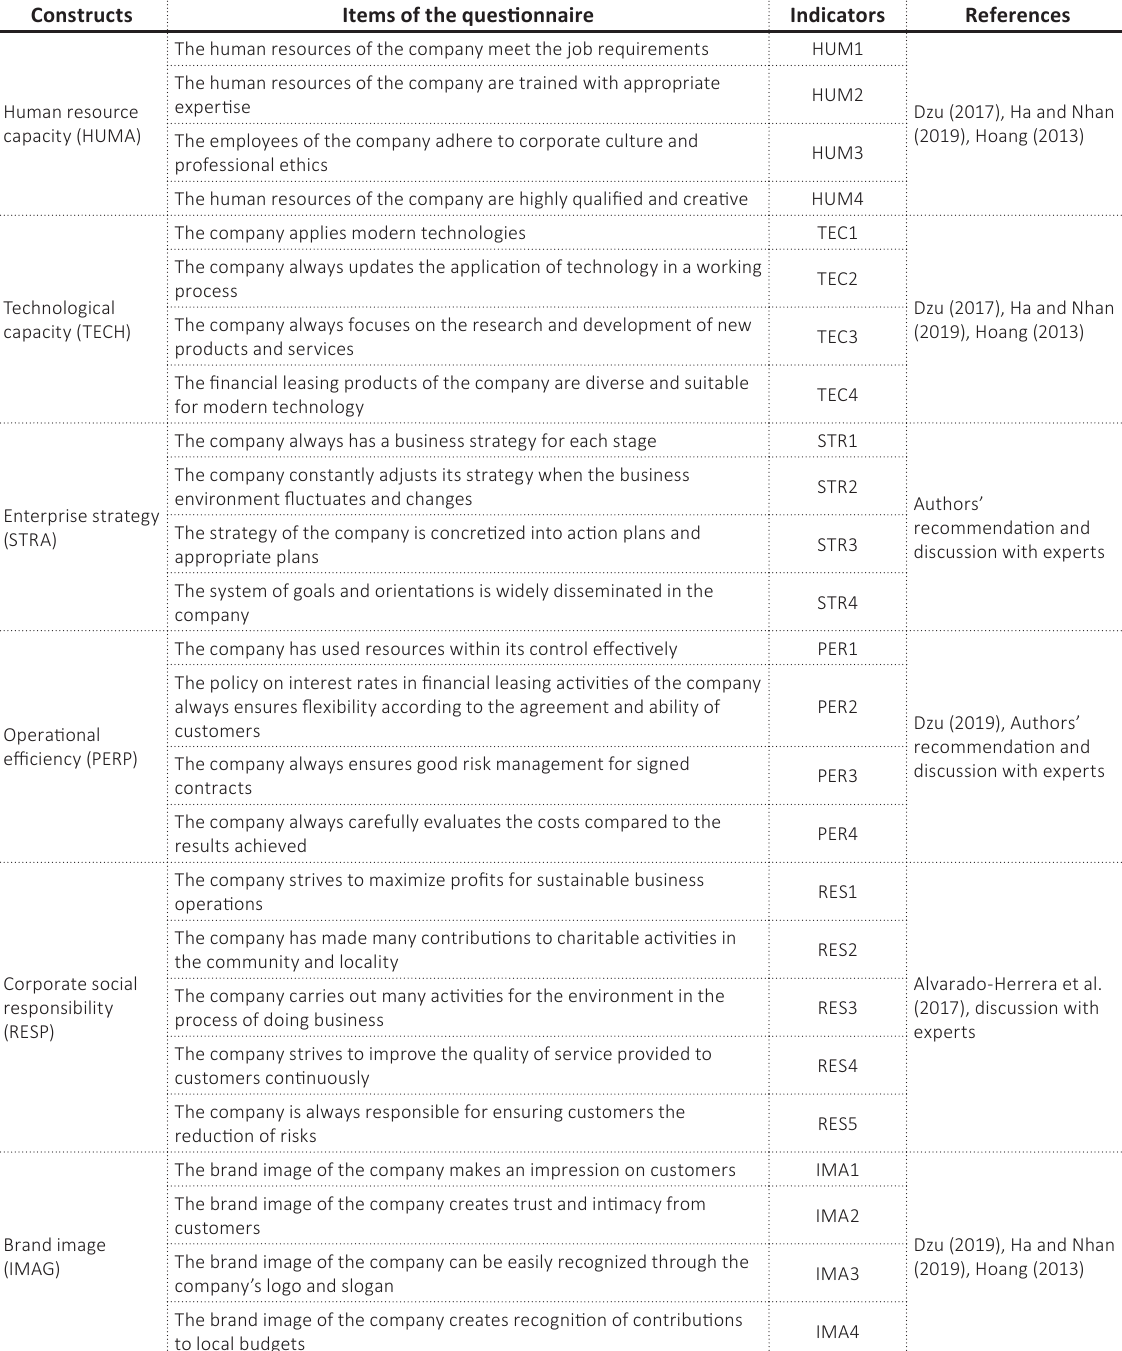
Table 1 (cont.). Constructs, indicators, and questionnaire items